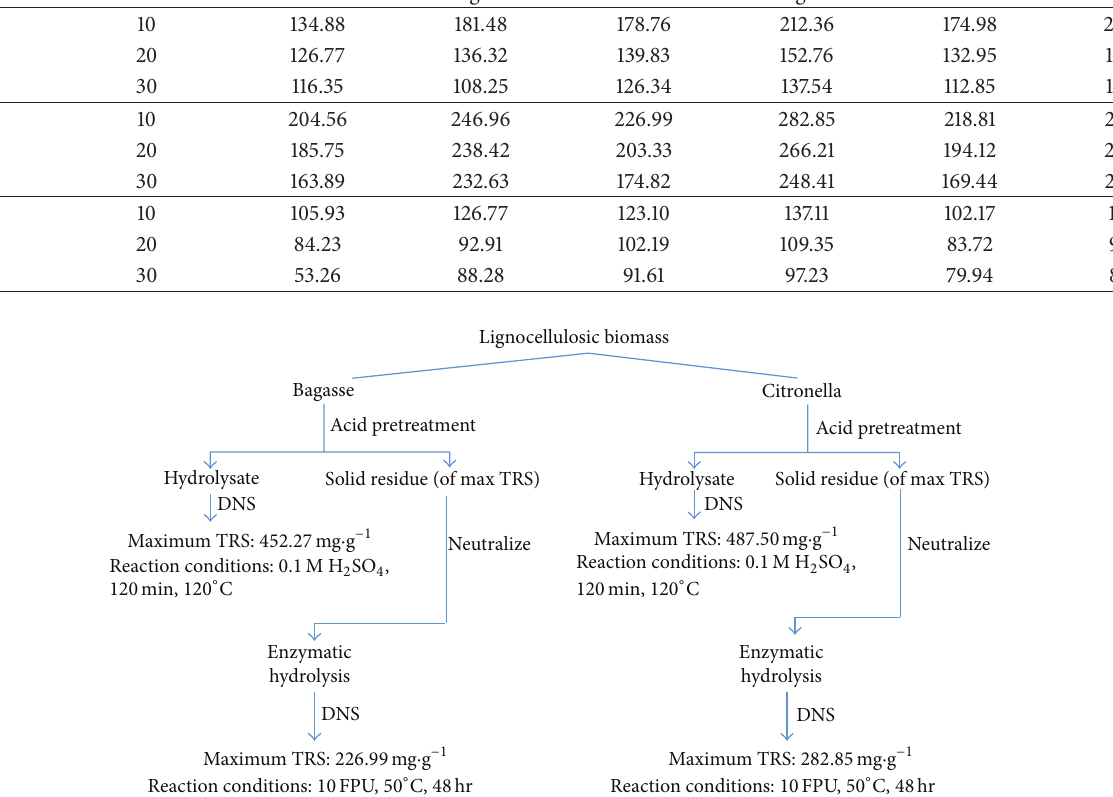
Table 3: Effect of temperature, time, and enzyme concentration on production of TRS during enzymatic hydrolysis of citronella and bagasse. Temp. ( ∘ C)